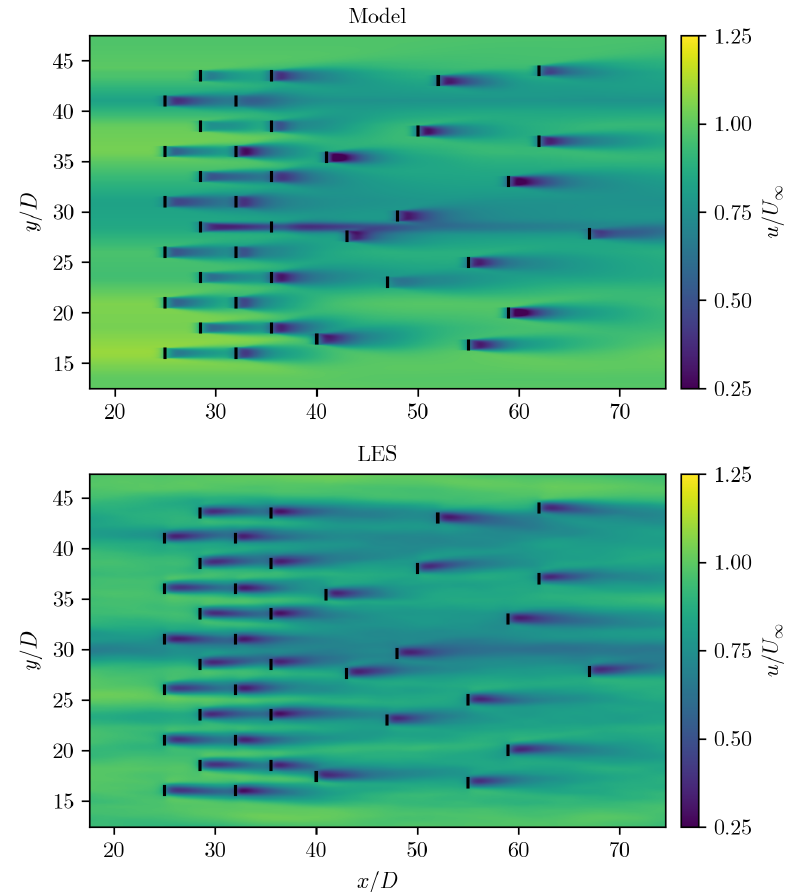
Figure 9. Comparison of state-estimated dynamic wake model velocity fields at t = 60 min and LES averaged between t 57.5 min and t = 62.5 ≈